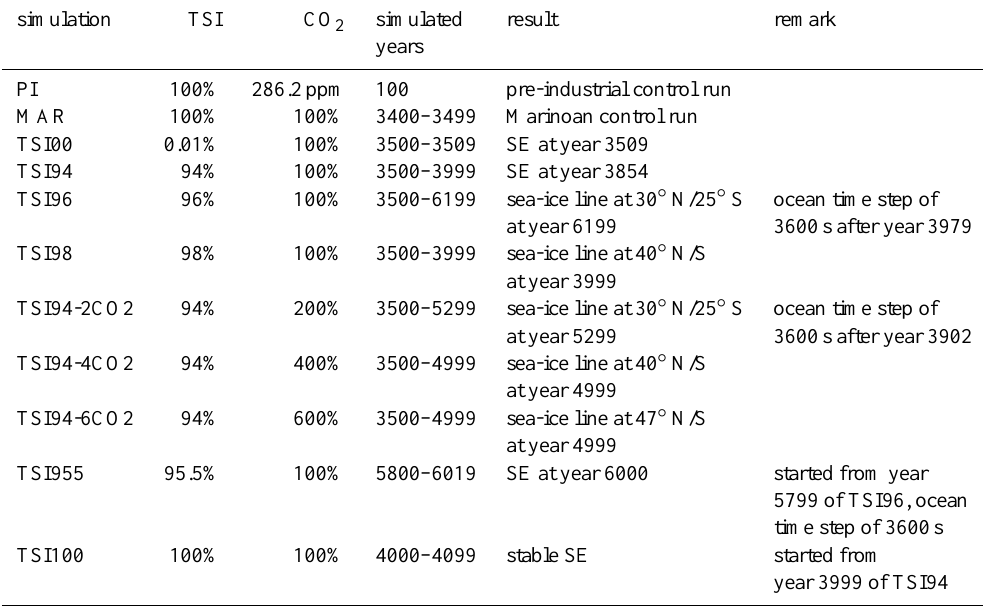
Table 2. Summary of ECHAM5/MPI-OM simulations. The applied total solar irradiance is given in percentage of the present-day value 1367Wm − 2 , atmospheric carbon dioxide in percentage of the pre-industrial level used in MAR. SE abbreviates Snowball Earth. Unless otherwise stated, simulations are started from year 3499 of